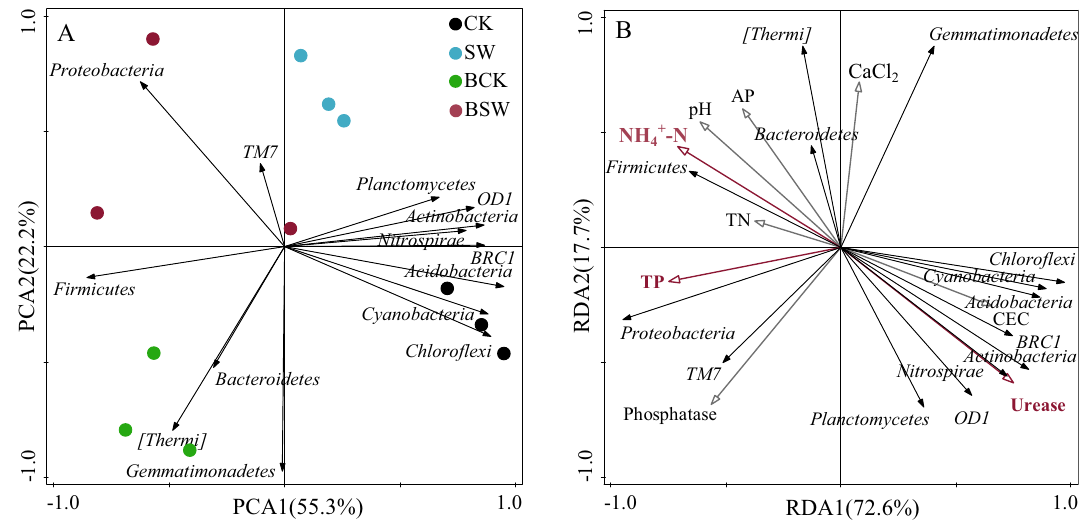
Fig. 4 The PCA plots of the beta diversity of soil bacteria ( A ) and redundancy analysis (RDA) of the correlations between bacterial communities and environmental parameters ( B ). CK: control; SW: soil treated with 1%‑biochar; BCK: soil treated with S. pasteurii ; BSW: soil treated with S. pasteurii and